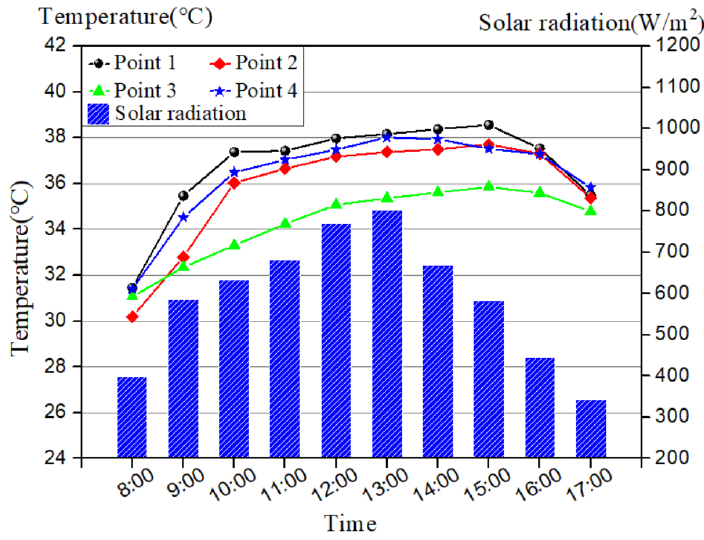
Figure 6. Air temperature and solar radiation at measuring points.